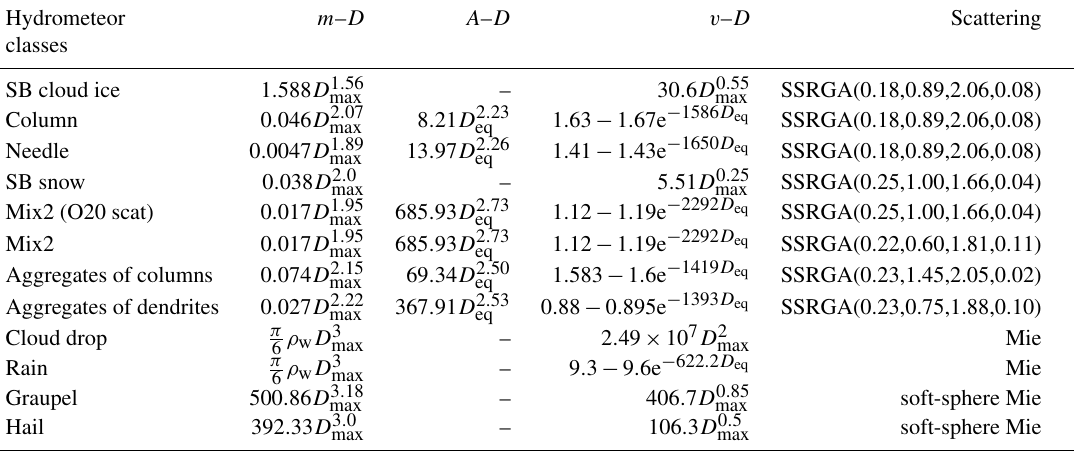
Table 2. Parameterizations used in ICON-LEM, the snowshaft model, and radar forward simulations of hydrometeor properties in PAMTRA. (cid:16) 6m (cid:17) 1 / 3 D represents the particle maximum dimension and D eq = the mass-equivalent diameter; m is the particle mass and ρ w the density πρ w of water. The mass–size ( m – D ), terminal velocity v t –size, and projected area–size ( A – D ) relations are reported in their full mathematical form. For the SSRGA scattering model, the four parameters ( κ , β , γ , ζ 0 ) are given in parentheses. SB indicates that the properties are exclusively used in the default setup. Cloud droplets, rain, graupel, and hail (which are only relevant for the 3D simulations) follow the same properties in all simulations. The aspect ratio is 1.0 for all classes except for the snow classes (SB snow, Mix2, and Mix2; O20 scat), for which an aspect ratio of 0.6 is assumed. All variables are in SI